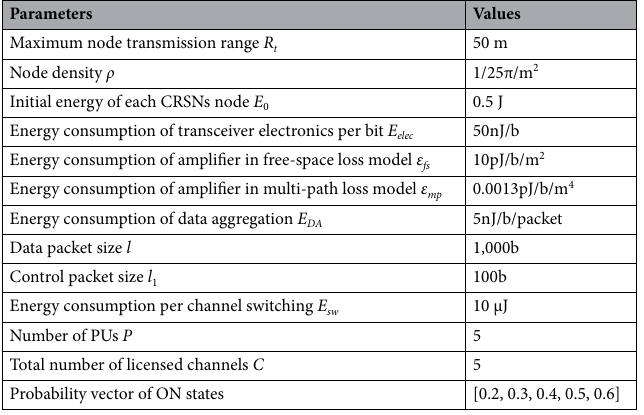
Table 2. Simulation parameter